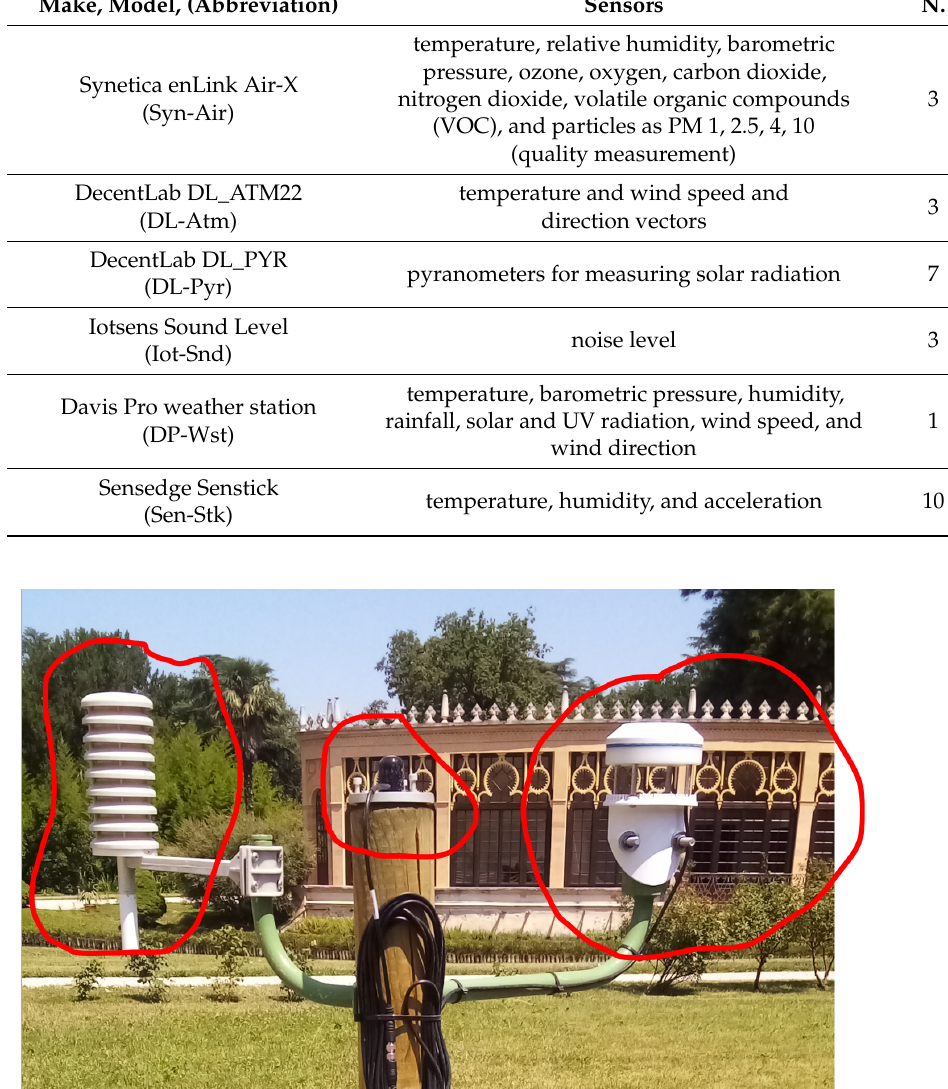
Table 1. List of sensors and models, with the number (N) installed in the garden.